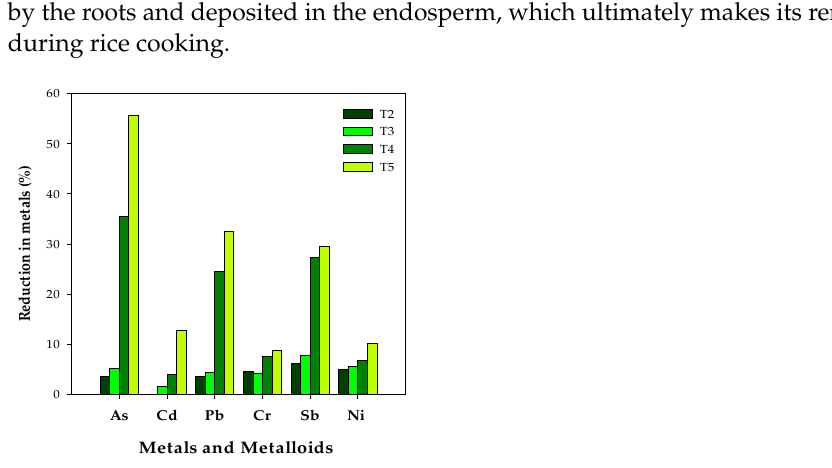
Figure 1. Effect of cooking treatments on As ( a ), Cd ( b ), Pb ( c ), Cr ( d ), Sb ( e ), and Ni ( f ) contents in Hassawi rice; similar letters on bars are non-significant among each other ( p > 0.05); MAC means maximum allowable concentration by FAO/WHO; for Sb and Ni, the maximum allowable concen- tration is not defined.